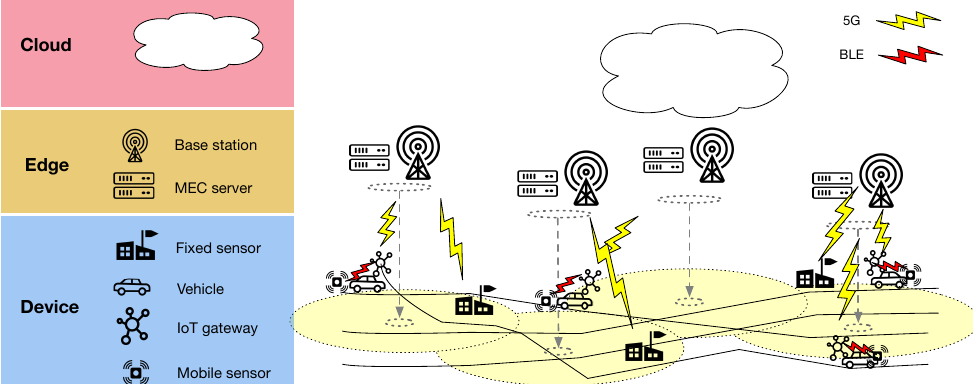
Figure 9. EDISON with Multi-Access Edge Computing (MEC). Coverage of each base station shown in yellow. Adapting EDISON for MEC requires a rethinking of the cluster architecture, based now around the BS locations. Further, due to the near-constant connectivity offered by 5G, data flow in the distributed inference state must be carefully